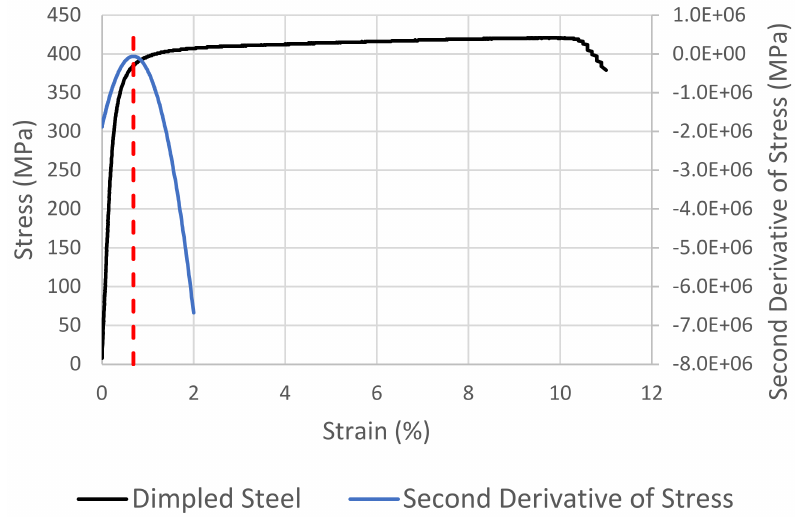
Figure 13. Derivative yield as applied to an experimentally measured stress–strain curve for dimpled steel subjected to tensile loading.